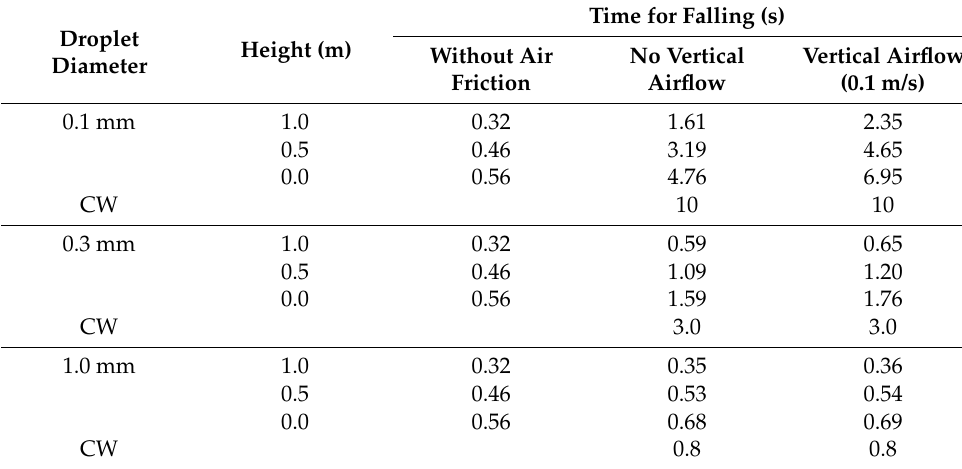
Table 2. Droplet trajectories for various droplet sizes *. Droplet